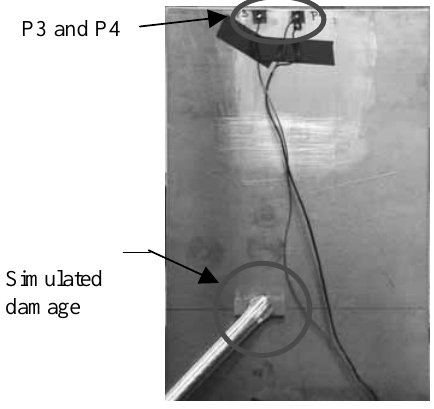
Fig. 8. Damage I (between P1 and P3) introduced to the Plate, as a simulated crack.